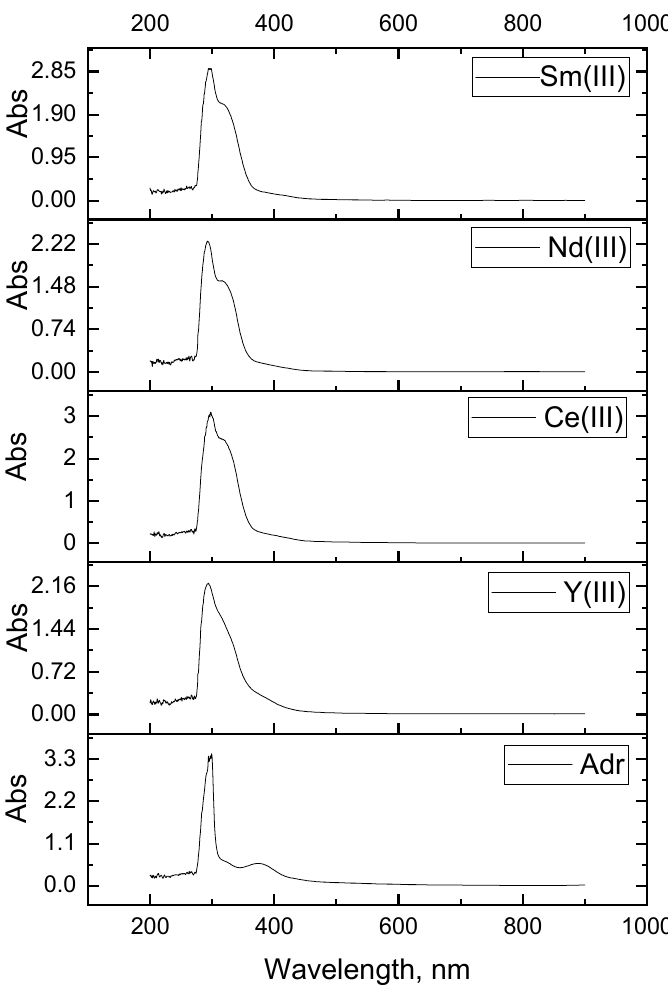
Figure 4. Electronic spectrum of adrenaline free and their complexes [Y 2 (Adr) 2 (H 2 O) 8 ]Cl 3 ·8H 2 O, and [Ce(Adr) 2 (H 2 O) 2 ]Cl 3 ·10H 2 O, [Nd(Adr) 2 (H 2 O) 2 ]Cl 3 ·6H 2 O, Sm(Adr) 2 (H 2 O) 2 ]Cl 3 ·12H 2